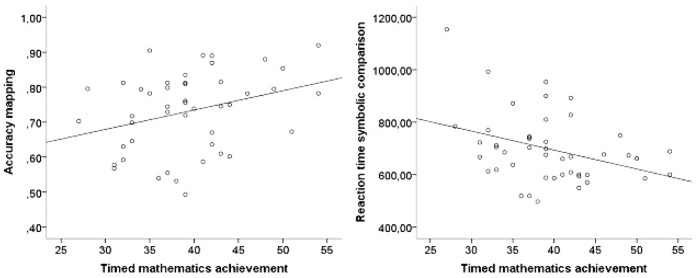
Scatterplots showing the significant associations between the numerical magnitude processing tasks and timed mathematics achievement in Grade 3.